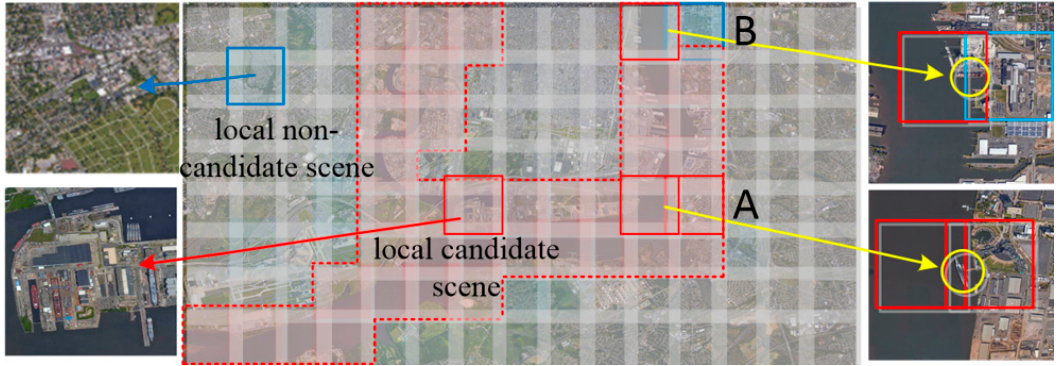
Figure 6. Extraction results for local candidate scenes using the L (cid:2870) CSN.